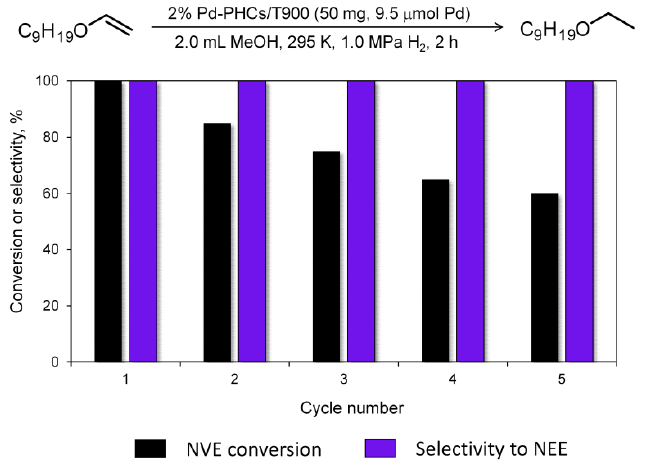
Figure 5. Reusability testing of the 2% Pd-PHCs/T900 catalyst in the hydrogenation of NVE.